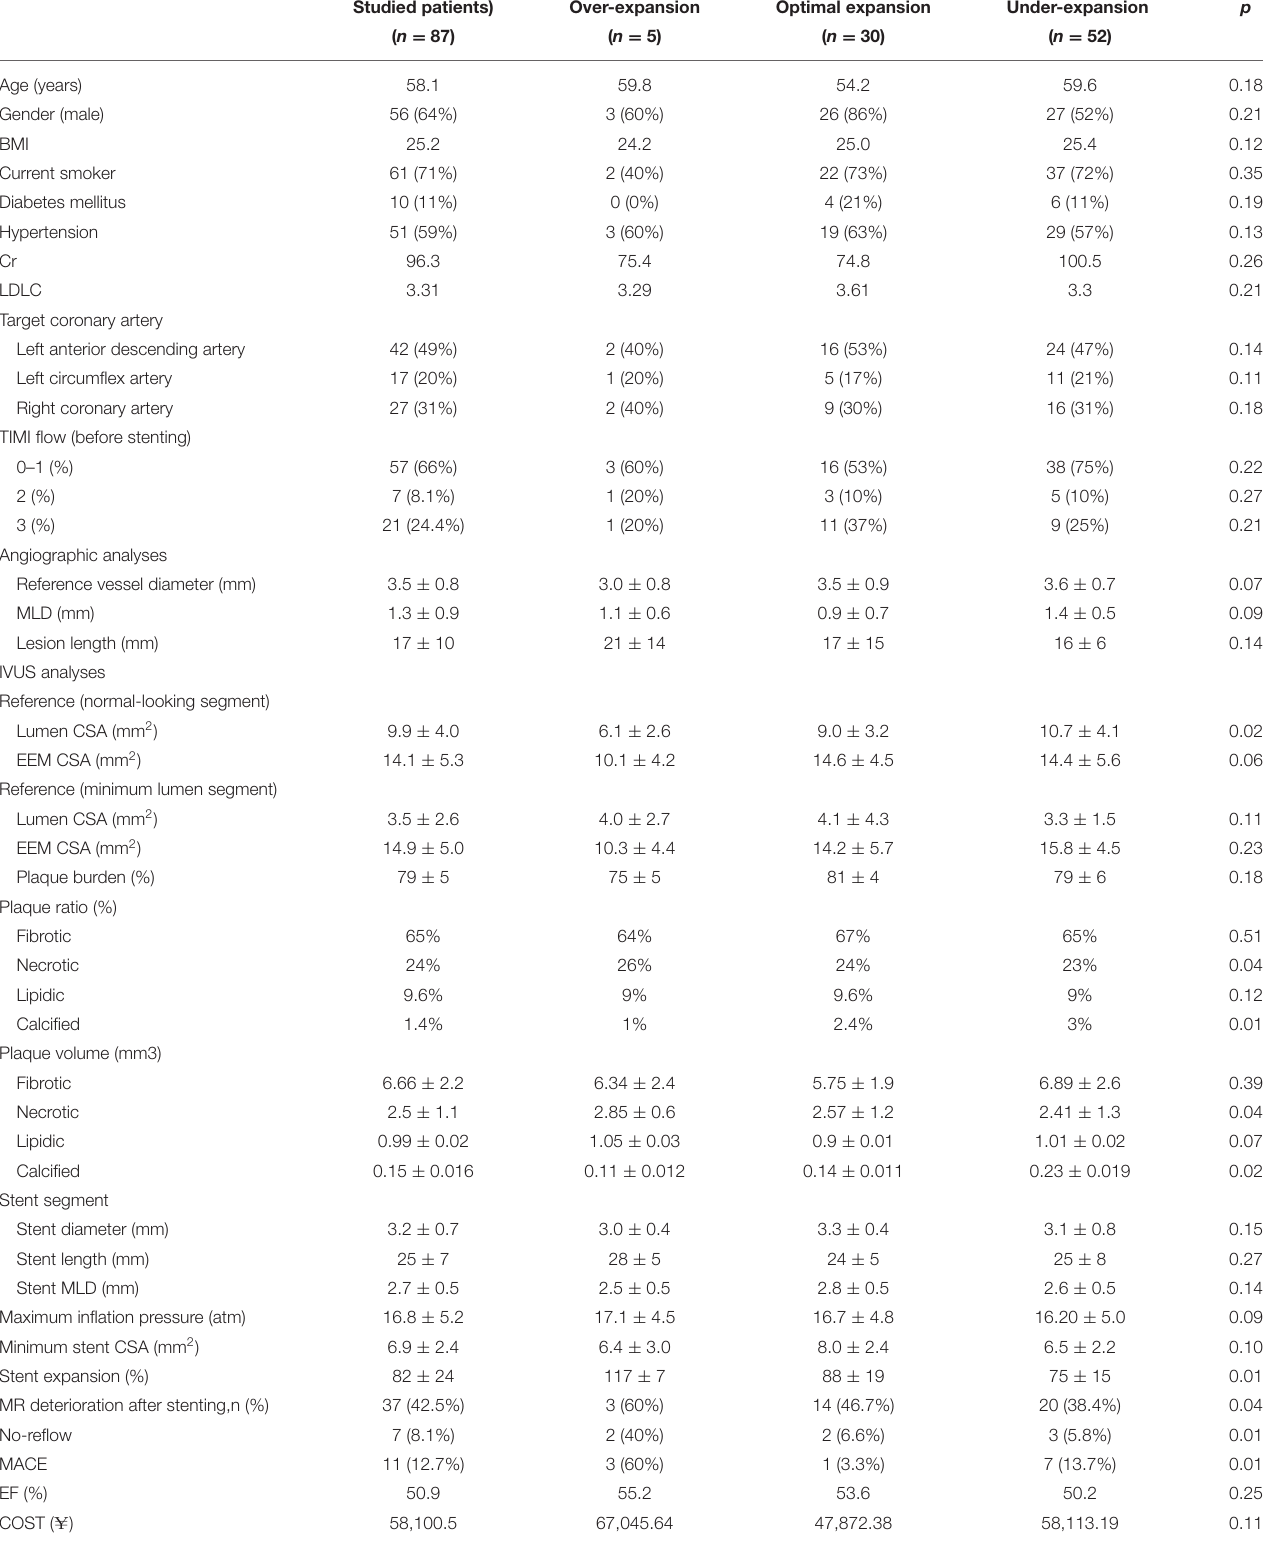
TABLE 1 | Baseline demographic, QCA, and IVUS characteristics of the patients. Studied patients) Over-expansion Optimal expansion